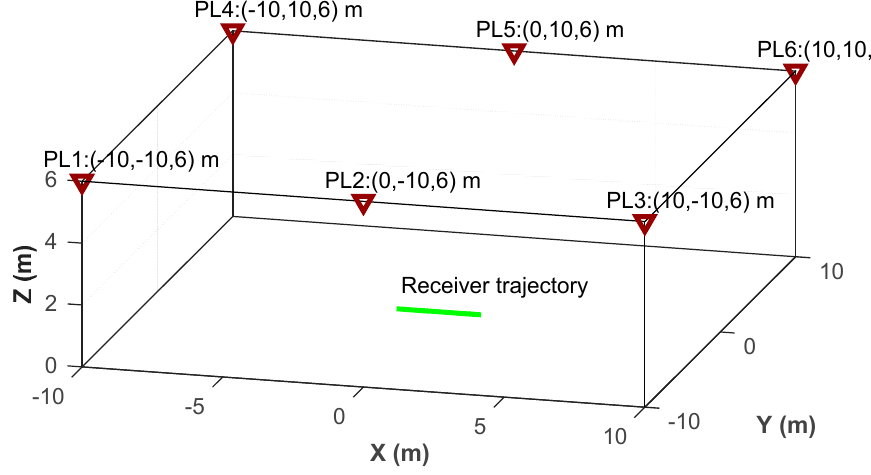
Figure 5. Sketch of the pseudolite system in the simulation.